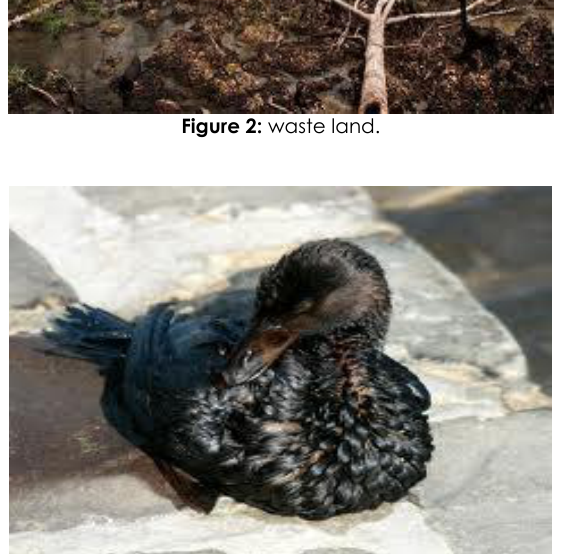
Figure 3: Loss in the